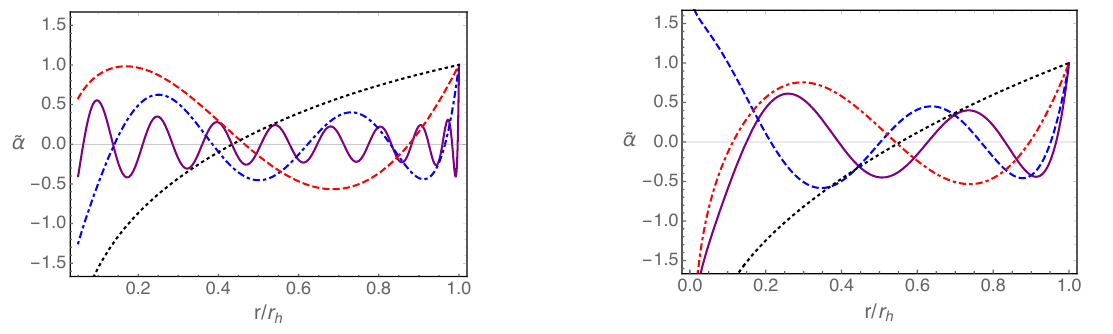
Figure 2 . The plots of ˜ α = α/α h along radial direction in the oscillation region for fixing α b = 0 . 1 ( left ) while T/k = 0 . 015 (purple), 0 . 05 (blue), 0 . 1 (red), 0 . 3 (black), as well as for fixing T/k = 0 . 05 ( right ) while α b = 0 . 1 (purple), 0 . 3 (blue), 0 . 5 (red), 1 (black). Here α h is the horizon value of α